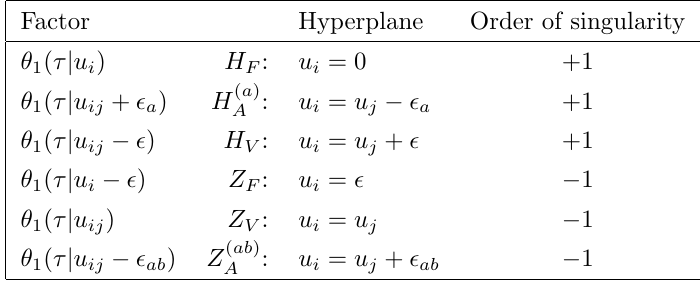
Table 2 : Contributions to the order of singularity from the integrand in (2.4). tree diagram with k nodes. Up to Weyl permutations, the (cid:12)rst coordinate is u each coordinate di(cid:11)ers from one of the previous ones by either (cid:15) or (cid:0) (cid:15)